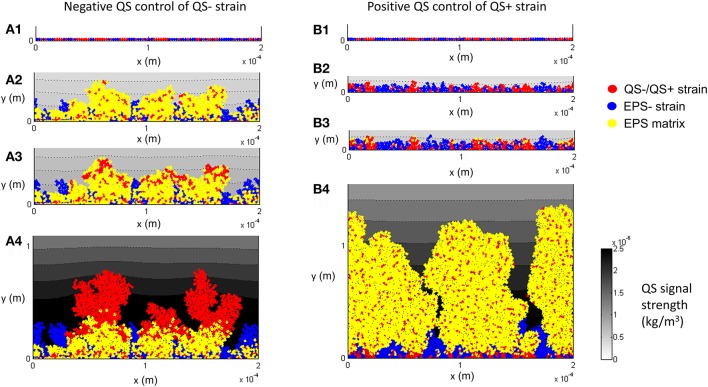
EPS production is negatively (A1–A4) and positively (B1–B4) controlled through quorum sensing (f = 0.5, τ = 5 × 10−7 kg/m3): (A1) both QS− and EPS− strains are randomly spread out on the substratum as individual cells; (A2) biofilm after 1.7 days; (A3) biofilm after 2.3 days, the QS− cells on the top of the biofilm gradually terminate the production of EPS; (A4) biofilm after 7 days, there is no EPS on the top of QS− linages. (B1) both QS+ and EPS− are randomly spread out on the substratum as individual cells; (B2) biofilm after 1.0 days; (B3) biofilm after 1.3 days, QS+ strain starts to produce EPS; (B4) biofilm after 7 days, QS+ strain dominates in the biofilm due to EPS matrix. All values are in SI units.